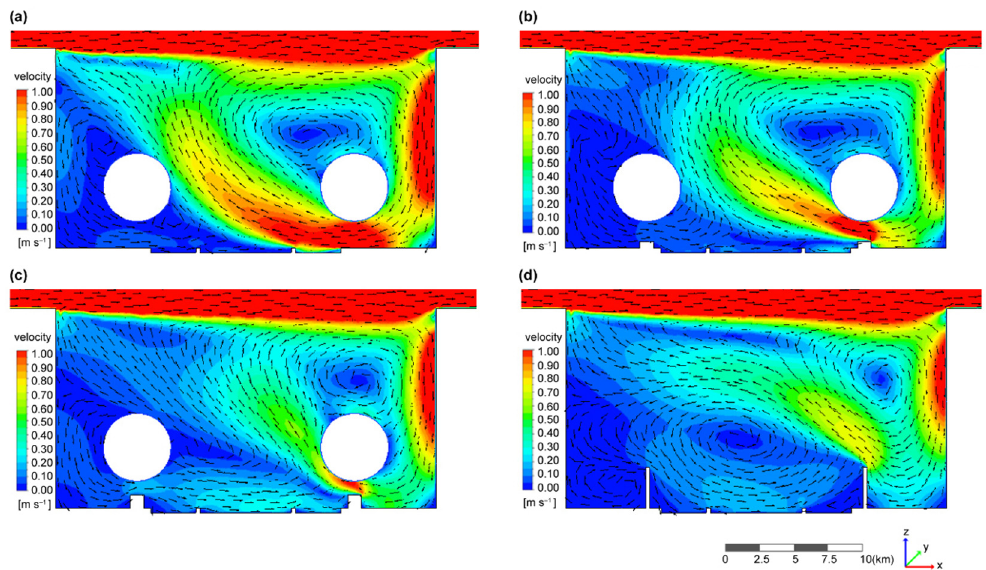
Figure 3. Velocity contours and vectors in the four-lane road, reproduced by numerical simulations with different vegetation configurations; scenario: ( a ) a single-layer planting (F1), ( b ) multi-layer configurations with shrub heights of 50 cm (F2), ( c ) multi-layer configurations with shrub heights of 1 m (F3), and ( d ) vegetation barrier (F4).